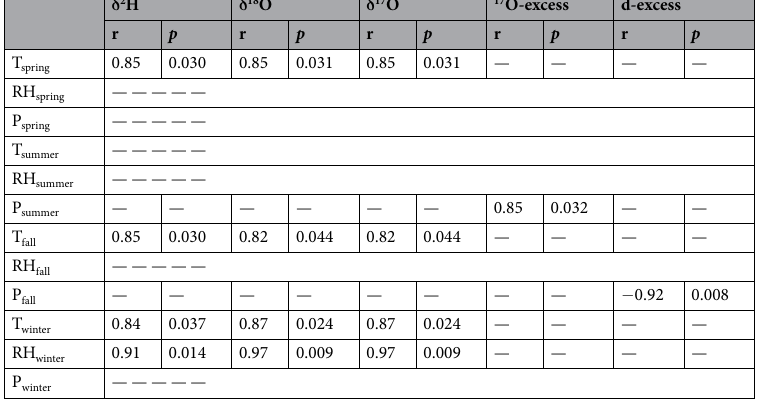
Meteorological variables. In order to investigate the effects of meteorological factors on isotopic variations